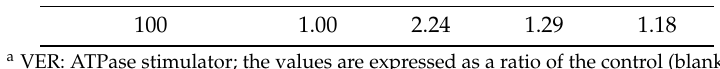
Table 2. Effect of piperazine derivatives and verapamil on P-gp ATPase activity. Comp Conc. ( µ